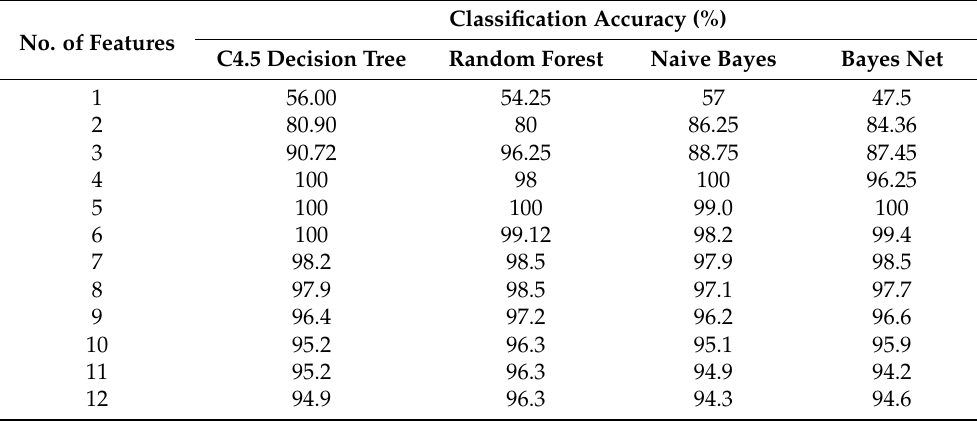
Table 5. Effect of the number of features on classification accuracy—simulated